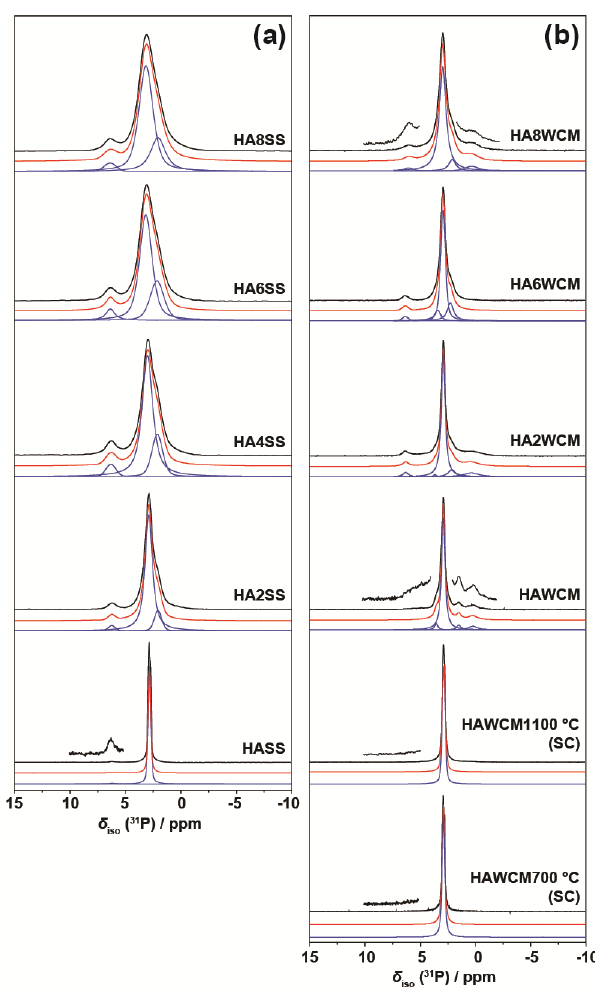
Figure 8. The 31 P MAS NMR data ( ν 0 ( 31 P) = 242.96 MHz, ν r = 12 kHz) showing the experimental spectra (black), total simulated spectra (red), and deconvoluted resonances using Gaussian line shapes (blue) from the suites of Cu-doped HA samples prepared by the ( a ) solid-state and ( b ) wet chemical synthetic routes.